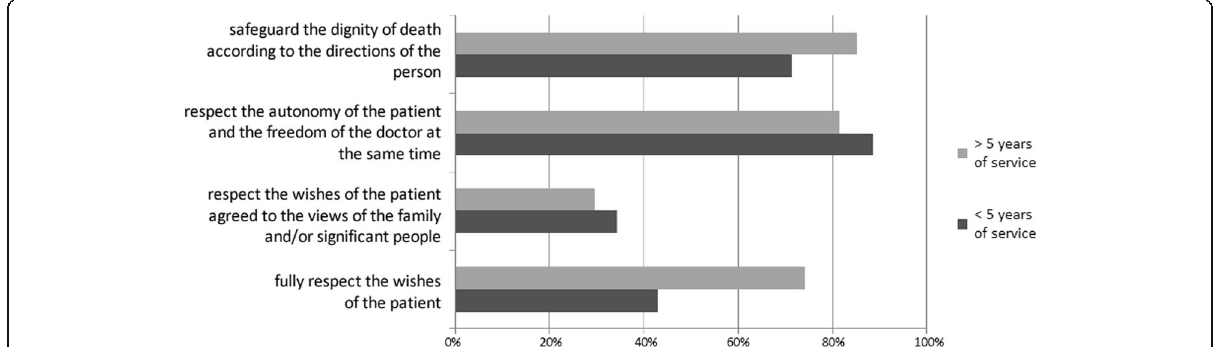
Fig. 3 Graph of Respect of willigness of the patient. Legend: Percentage of answeres related to years of service of health